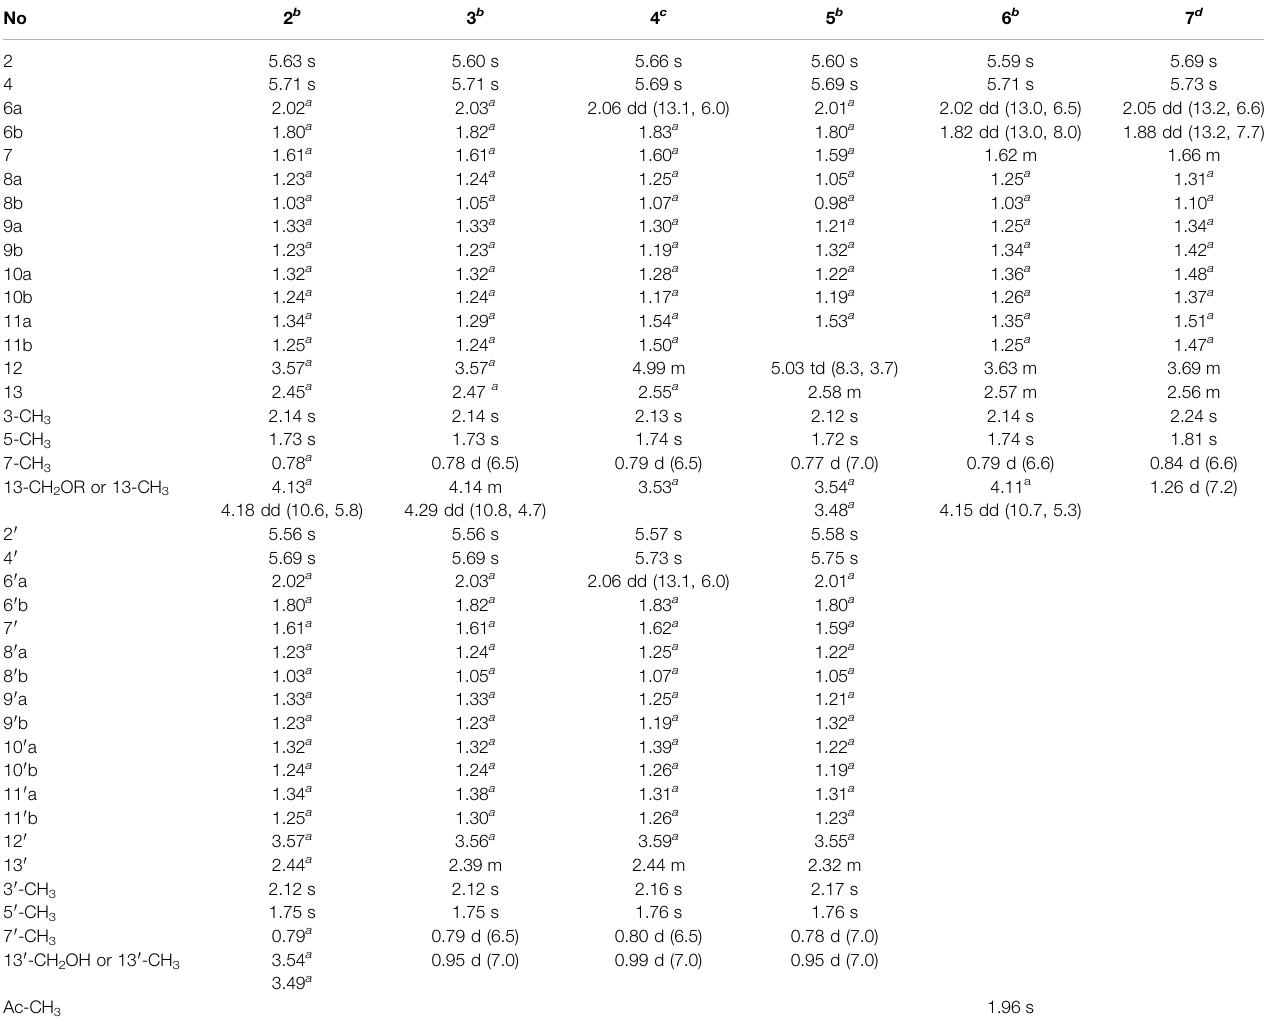
TABLE 1 | 1 H NMR Data of Compounds 2 – 7 ( δ in ppm, J in